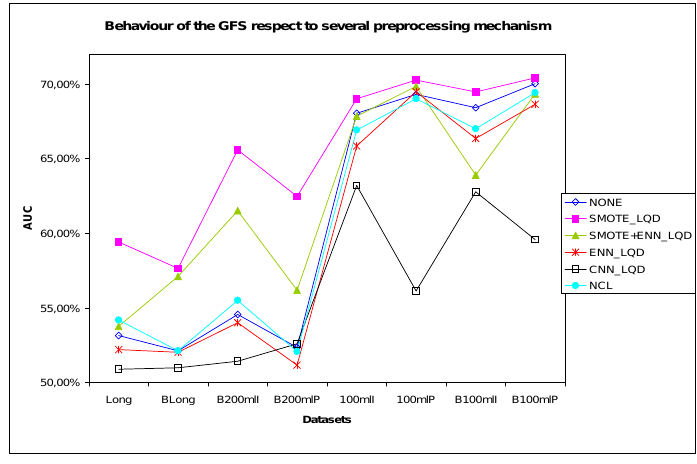
Figure 8: Behaviour of low quality data in the GFS respect to several preprocessing mechanisms (upper bound of AUC